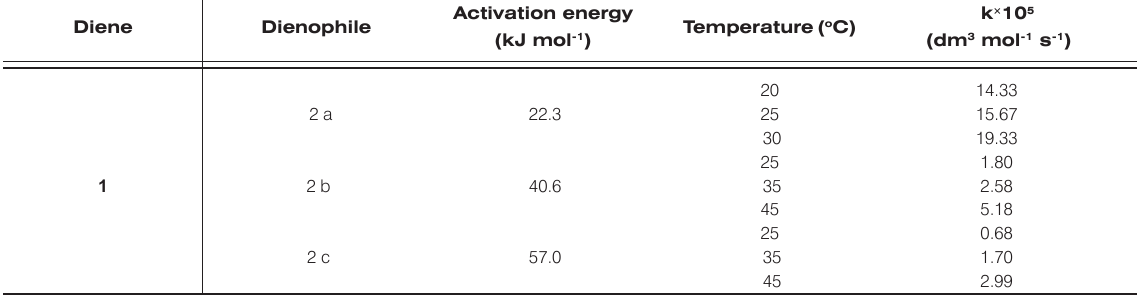
Table 2. TON and endo:exo ratios in the Diels-Alder reaction between cyclopentadiene (1) and dienophiles (2a-c) carried in catalytic systems metal salt + [hpy][NTf ] 2 Dienophiles 2 a